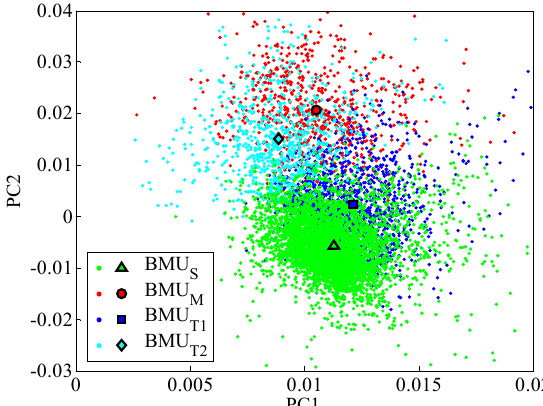
Figure A1. The detected Kuroshio surface axis results from 1993 to 2016 and winning neurons projection on the first two principal components.